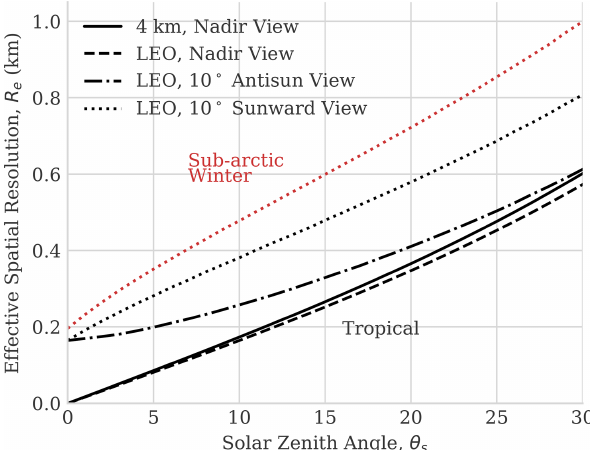
Figure 4. The effective spatial resolution as a function of solar zenith angle θ s , at both 4km and low-Earth-orbit (LEO) acquisition altitudes. The red line shows a sub-arctic winter atmospheric profile indicating the range of spatial resolution across two very different atmospheric conditions. In reality, the sun never reaches low zenith angles in polar regions of the